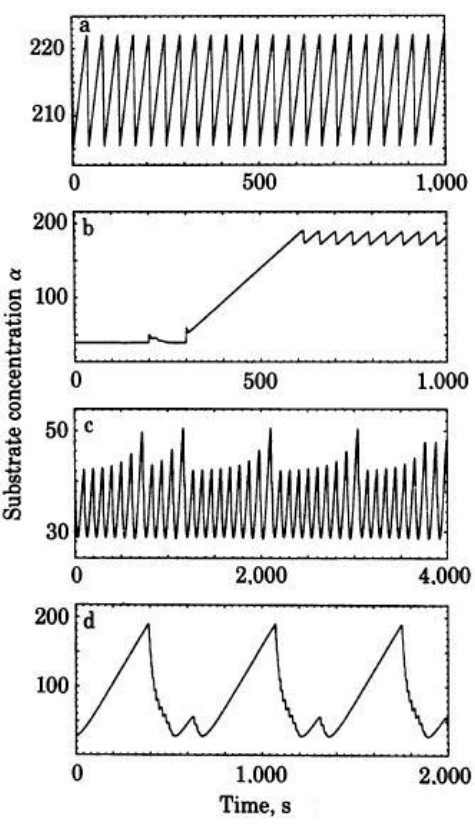
Figure 1. Diversity dynamic behaviors emerge in the simple dissipative metabolic subsystem. ( a ) Periodic pattern. ( b ) Hard excitation, the integral solutions depending on the initial conditions settle on two regimens: a stable steady state and a stable periodic oscillation. ( c ) Chaotic oscillations. ( d ) Complex periodic behaviors. The substrate concentration  is represented as a function of the time in seconds. Reproduced with permission from PNAS